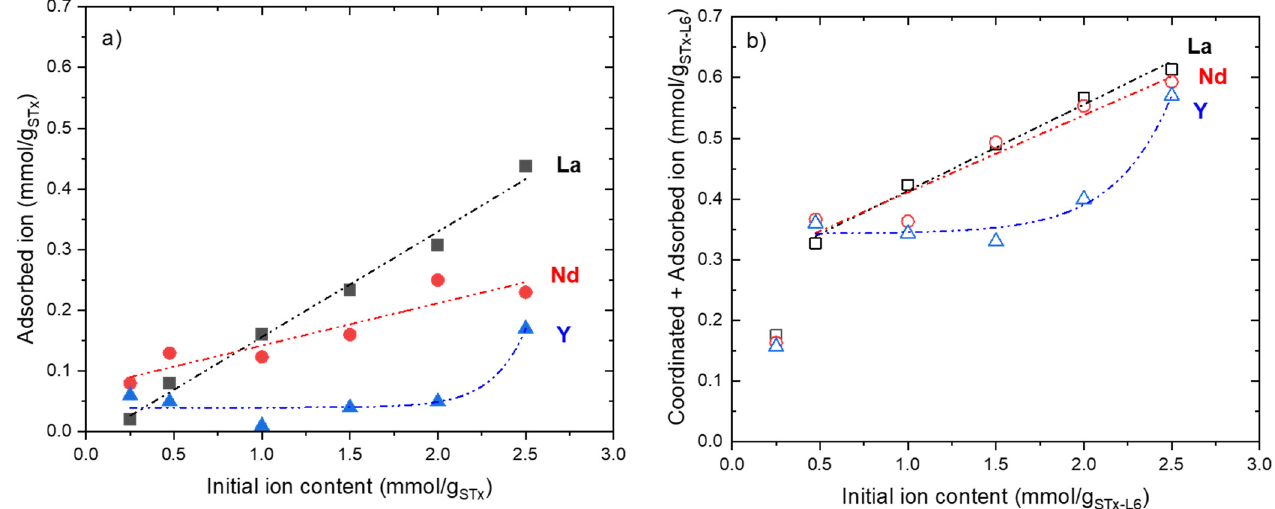
Figure 4. Adsorbed ions for pristine STx ( a ) and adsorbed plus coordinated ions for modified STx-L6 ( b ) as a function of the initial ion contents.